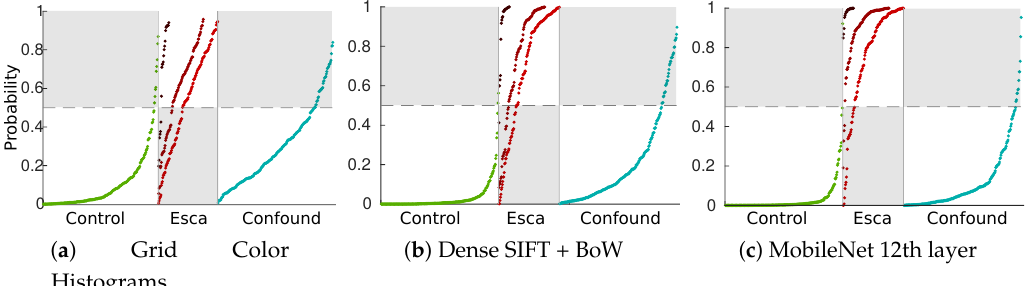
Figure 10. Repartition of sorted SVM esca probabilities ([47]) in the test set. Green plots: asymptomatic leaves; light red to dark red plots: esca symptoms subclasses (from weak to strong); blue plots: other